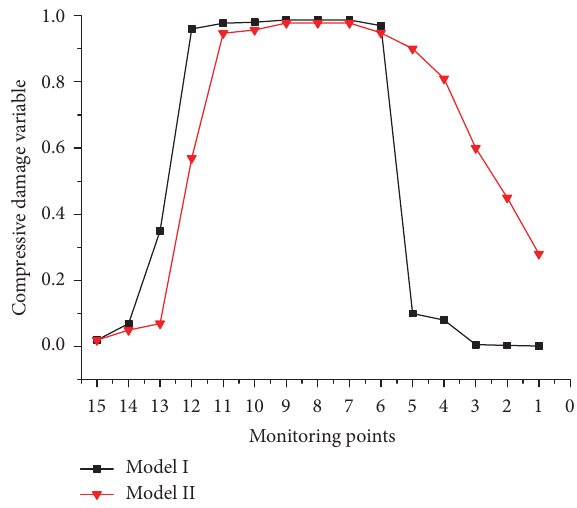
Figure 18: Compressive damage variable at each monitoring